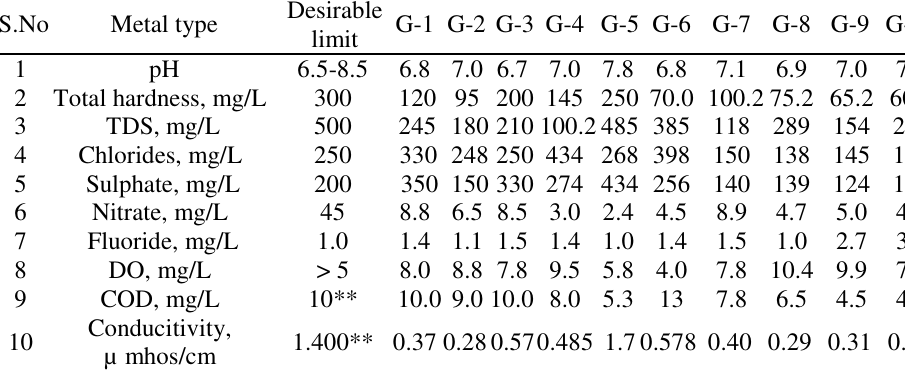
Table 5. The results of physicochemical studies for the groundwater